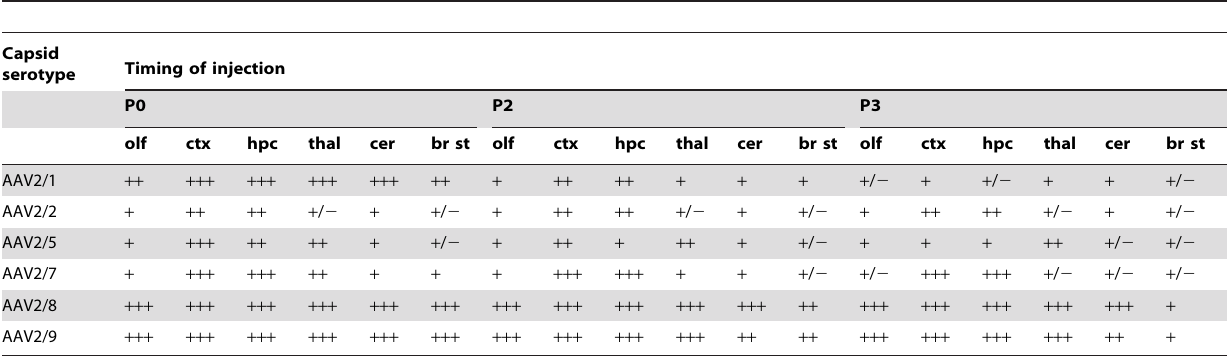
Table 1. Comparative summary of the effect of AAV capsid serotype and timing of injection on regional distribution of EGFP expression in neonatal mice.